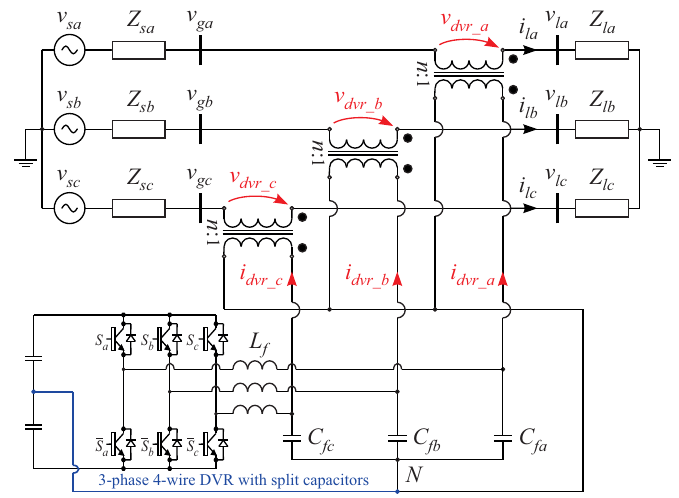
Figure 2. Three-phase circuit with a three-phase four-wire DVR with split